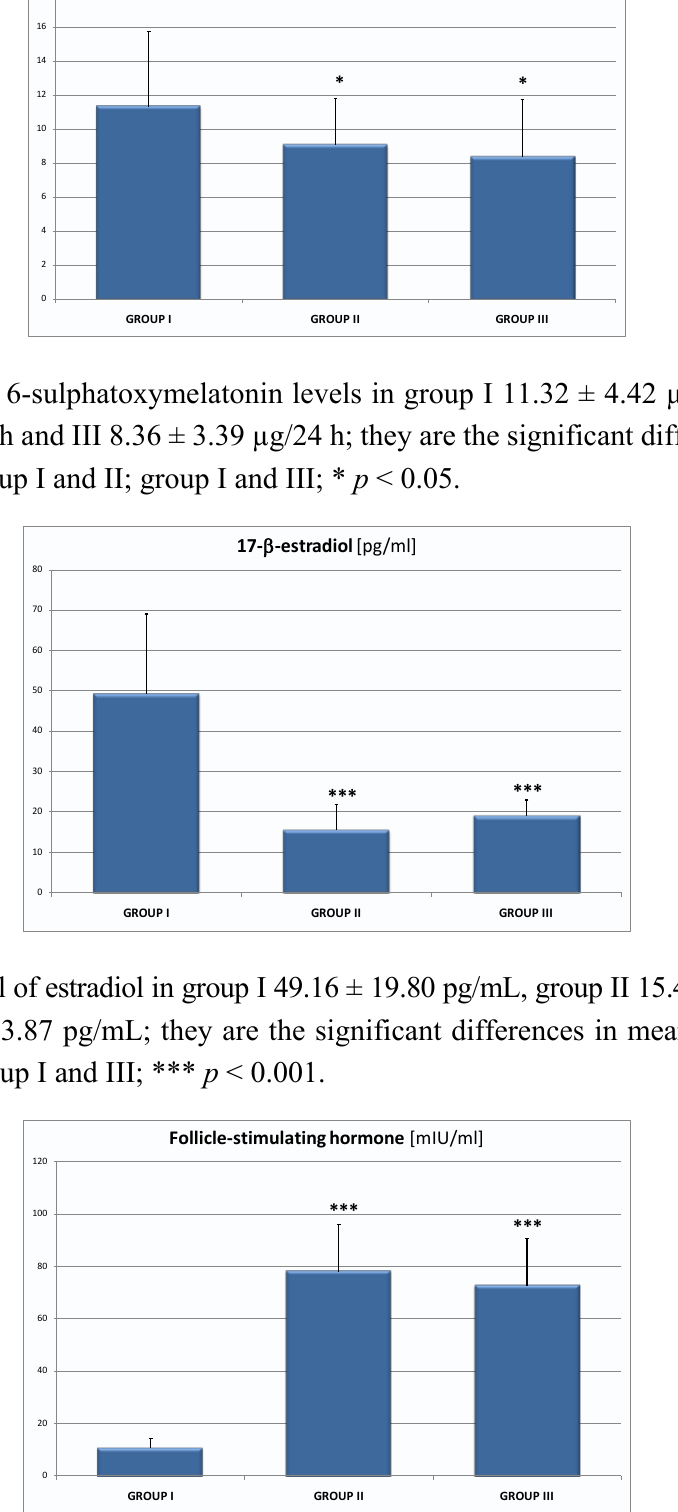
Figure 4. The level of follicle- stimulating hormone (FSH) in the groups: I—10.85 ± 3.40 mIU/mL, II—77.81 ± 18.20 mIU/mL ( p < 0.001), III—72.63 ± 18.07 mIU/mL; they are the significant differences in mean value between group I and II; group I and III; *** p <